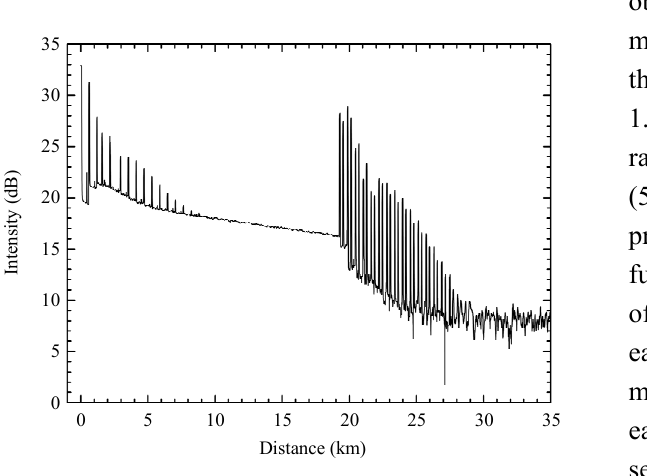
Fig. 7 OTDR trace obtained from the two rings in series configuration, representing the multiplexed